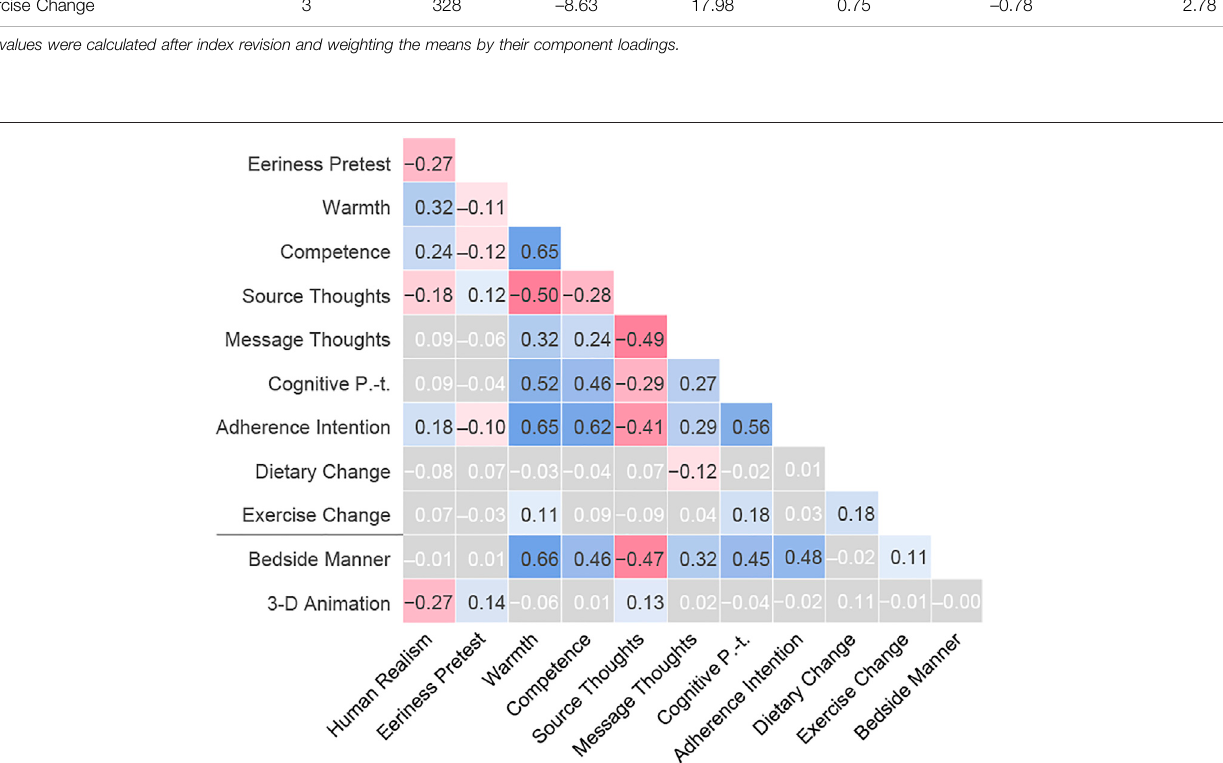
Table 1 . The initial indices and their factor loadings appear in the Supplementary Material . Correlations among independent and dependent variables (indices) are listed in Figure 2 . Manipulation Checks A two-way MANOVA indicated a signi fi cant effect of bedside manner, Pillai ’ s trace (cid:2) 0.49, F (4, 432) (cid:2) 105.00, p < 0.001, and depiction, V (cid:2) 0.19, F (16, 1740) (cid:2) 5.28, p < 0.001, on the manipulation check variables. Two-way mixed-effects models con fi rmed that bedside manner × depiction had only nonsigni fi cant interaction effects on Human Realism, pretest Eeriness, Eeriness, Warmth, and Competence. Mixed-effects models with planned contrasts were used for the manipulation checks.